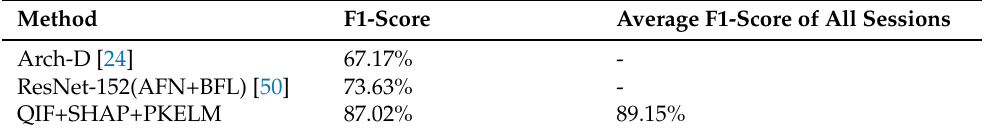
Table 10. Result of comparison with other methods of ingredient detection for VireoFood-172